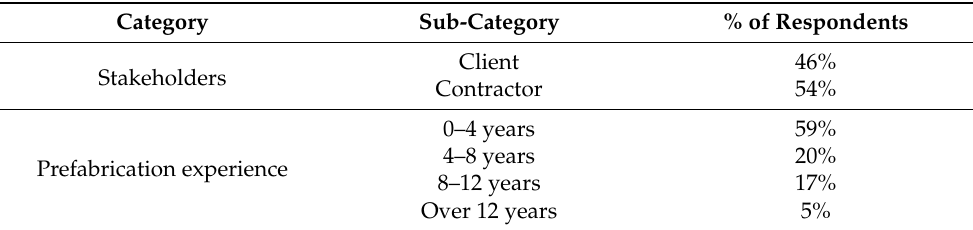
Table 1. Participants’ demographics.